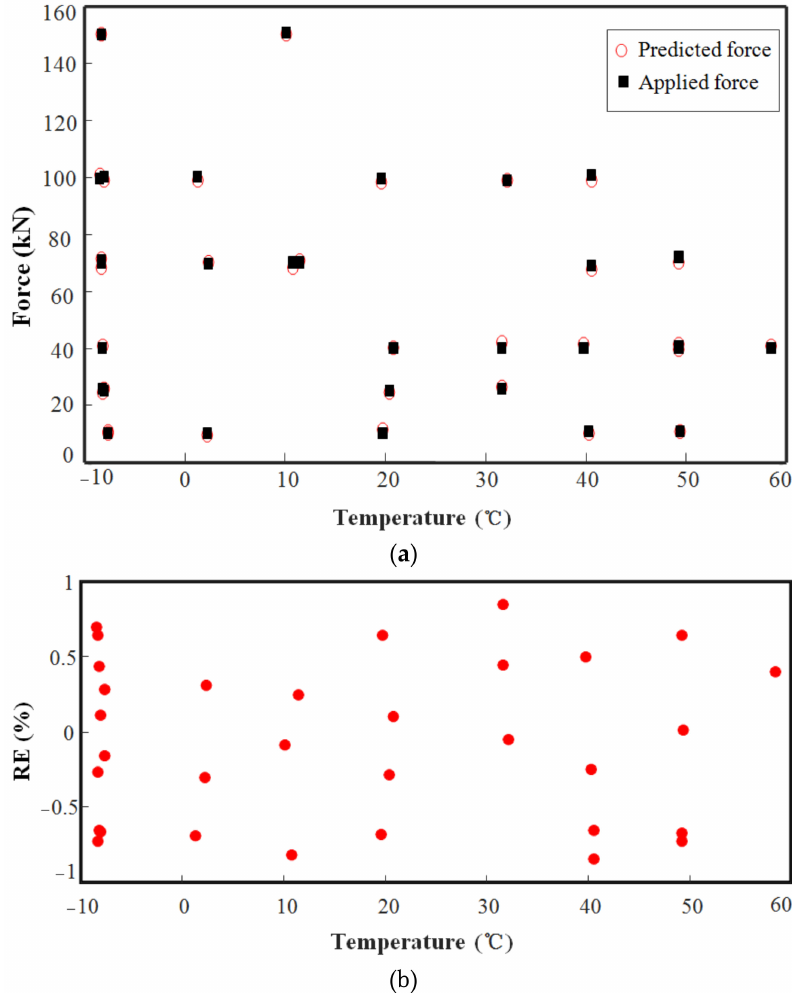
Figure 9. Compensation results obtained using BP neural networks: ( a ) Relationship betweenapplied force and predicted force after compensation at different temperatures; ( b ) RE of applied force and predicted